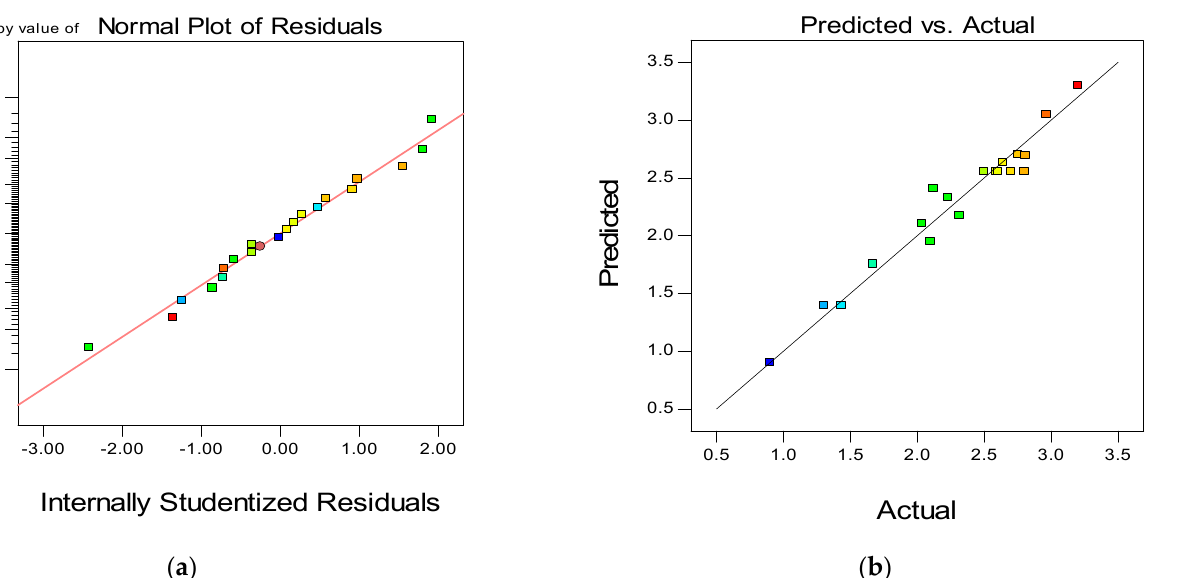
Figure 13. ( a ) Normal plot of residuals and ( b ) predicted versus actual plot for flexural strength.